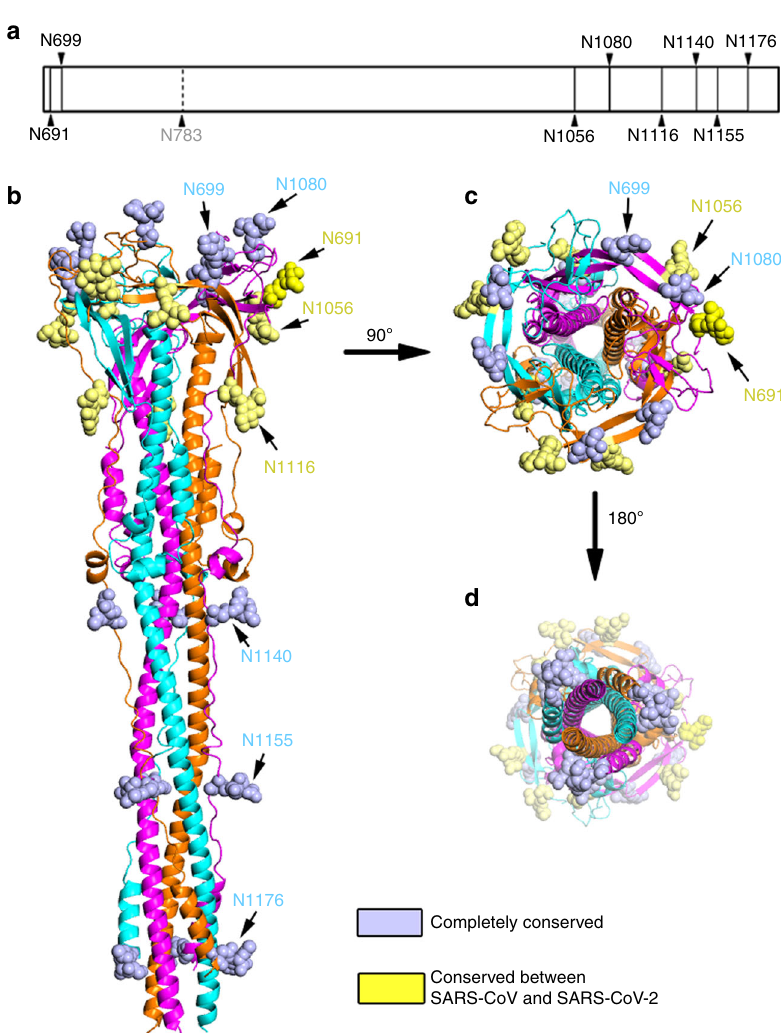
Fig. 5 Glycan shield of SARS-CoV S2 fusion machinery in post-fusion state. a Schematic diagram of the N-linked glycosylate modi fi cation sites of SARS- CoV S2 subunit. The visible N-linked glycosylation sites are shown in solid lines and the invisible N-linked glycosylation site is shown in dashed line. b – d The distribution of the glycan shield within the S2 subunit shown in side view ( b ), top view ( c ) and bottom view ( d ). The highly conserved glycosylation sites among coronavirus are shown as light blue spheres. The completely conserved glycosylation sites between SARS-CoV and SARS-CoV-2 are shown as yellow